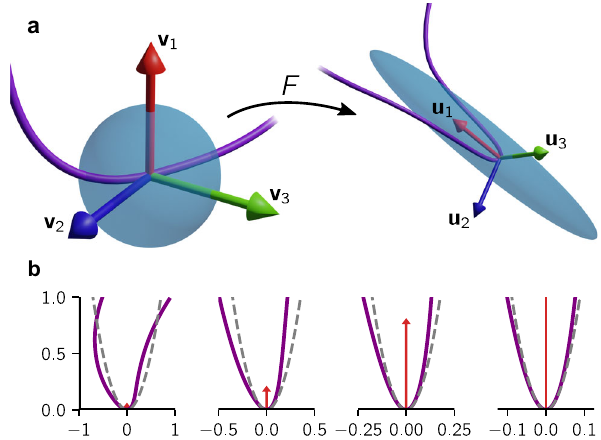
Fig. 4 Formation of a parabolic fold. a Illustration of the deformation tensor F . v i denote the principal axes of stretching before deformation and u i the corresponding axes after deformation. A fl uid element (blue) will be predominantly stretched along the direction of most stretching v 1 and compressed in the direction of most compression v 3 over time. If a material line element (violet) is initially orthogonal to the direction of most stretching, a fold will form. Such a fold is then compressed onto the u 1 – u 2 plane and tends to align with the u 1 direction along which it is ampli fi ed. b Stretching creates a locally parabolic curve. An initially non-parabolic curve is stretched vertically as indicated by the red arrows. Viewed on the appropriate horizontal scale, the line becomes increasingly parabolic. For comparison, the dashed line indicates a parabola with the same peak